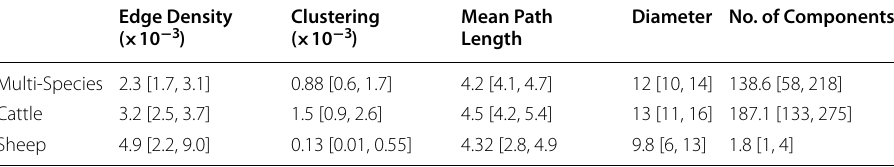
Average values are calculated over the thirteen 4‑week periods of the year 2016